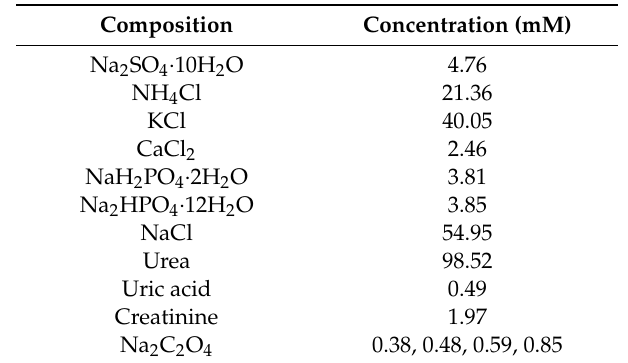
Table 2. The final concentrations of all the components at the point of mixing for the synthetic urine adopted in this